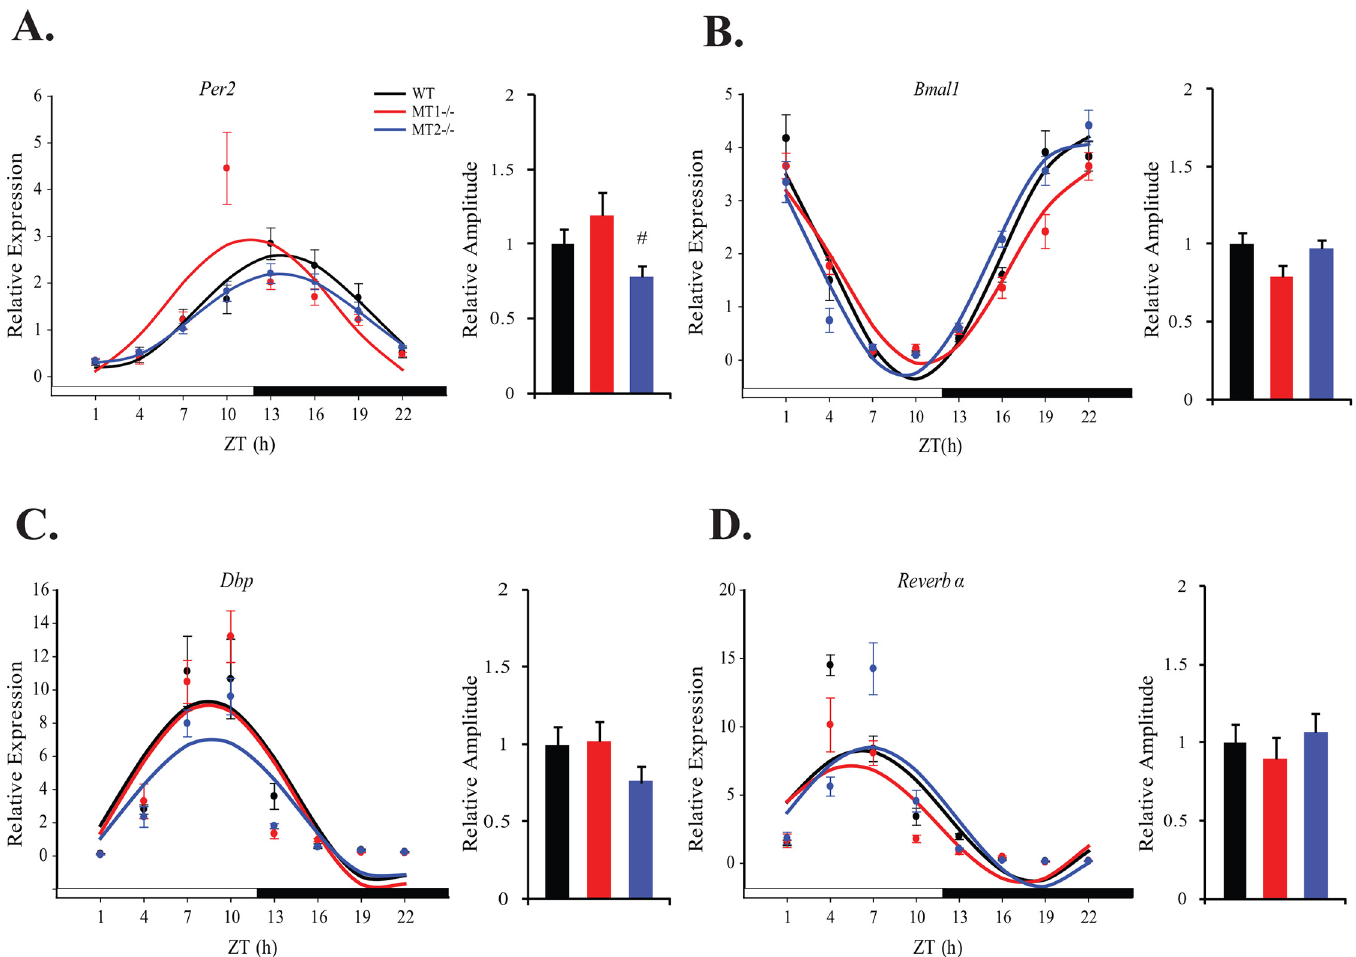
Fig 3. Expression levels of clock and clock controlled genes within liver of WT, MT1 -/- , and MT2 -/- mice. For each respective plot: the black circle (WT), red circle (MT 1-/- ) and blue circle (MT 2-/- ) indicate the expression levels of target genes calculated relative to the average expression of each dataset throughout the 24hrs. Results are represented as mean ± SEM. The black (WT), red (MT 1-/- ) and blue (MT 2-/- ) lines represent the periodic sinusoidal functions determined by COSINOR analysis (p < 0.05, (N = 4 – 6 for each time point and genotype). The bar graphs corresponding to each plot depict the amplitude of each oscillating transcript as calculated by COSINOR analysis and normalized to the value of the WT amplitude. # p < 0.05, One-Way ANOVA (post-hoc: Holm-Sidak) MT1 -/- vs. MT 2-/-